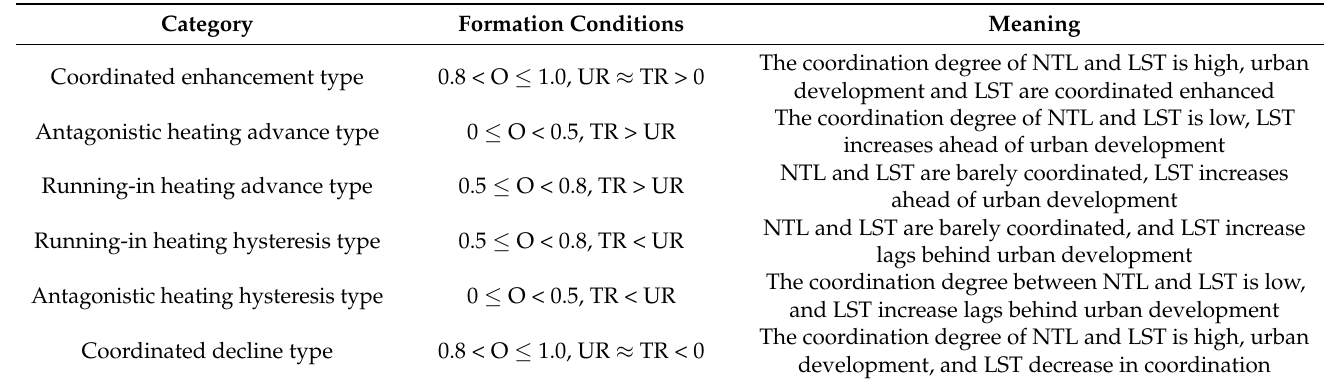
Table 2. Classification of coordinated change types between NTL and